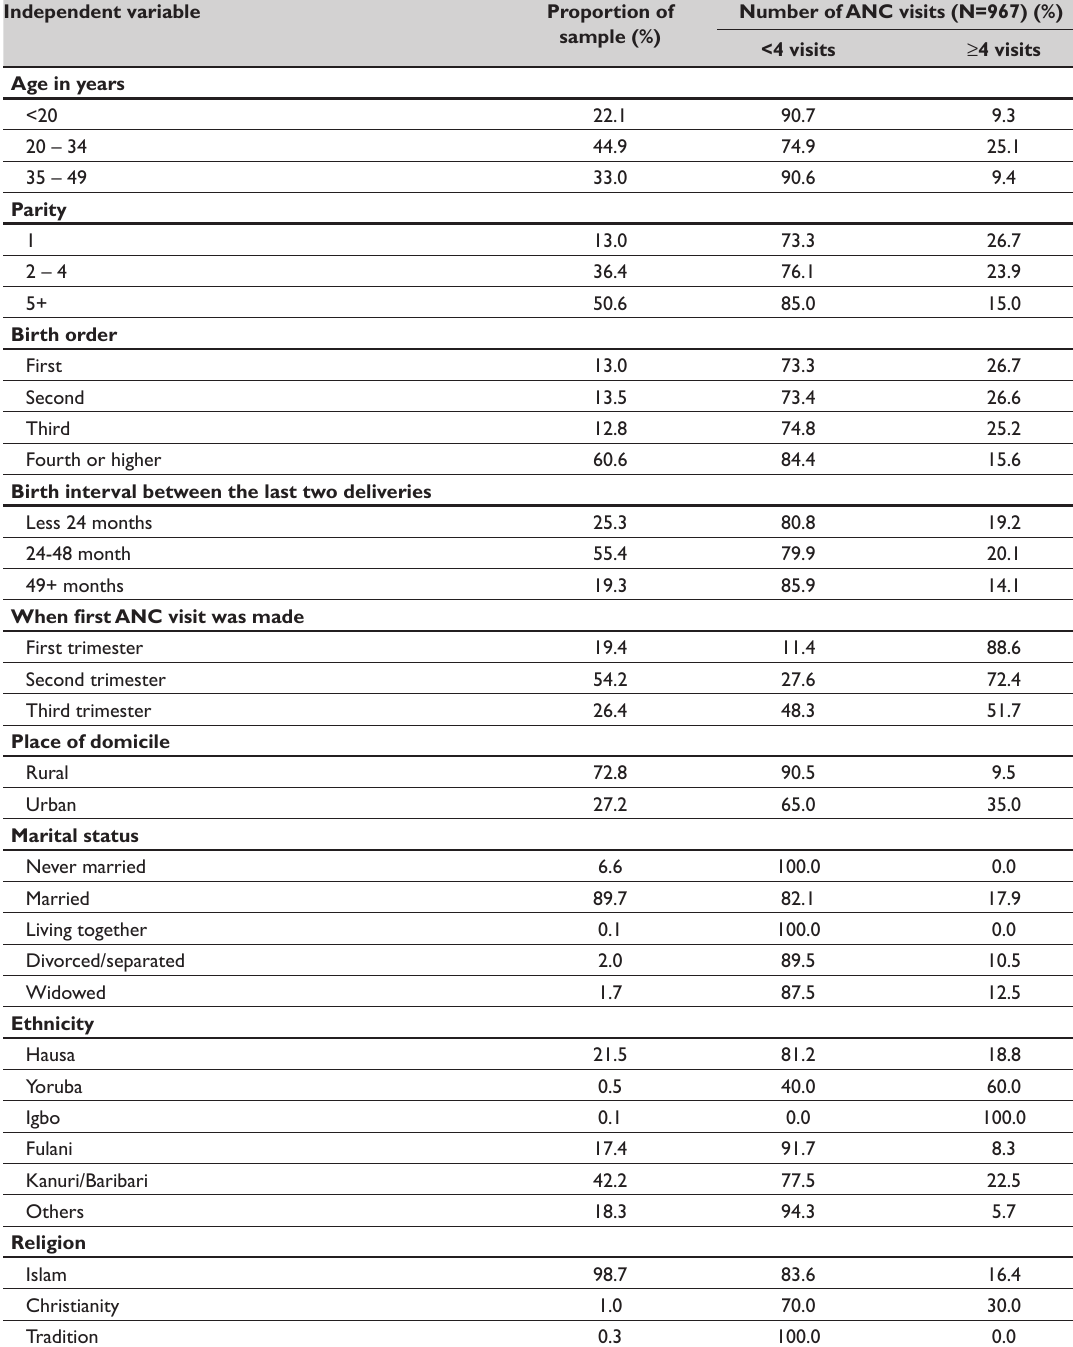
Table 1. Bio-socio-demographic Characteristics of Study